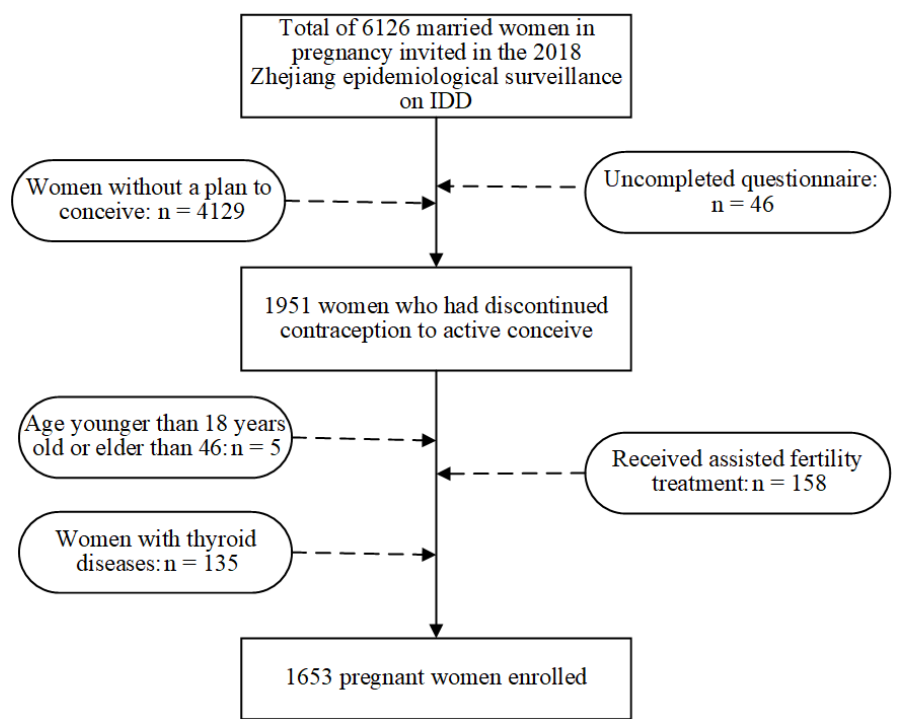
Figure 1. Study flowchart illustrating the study design.